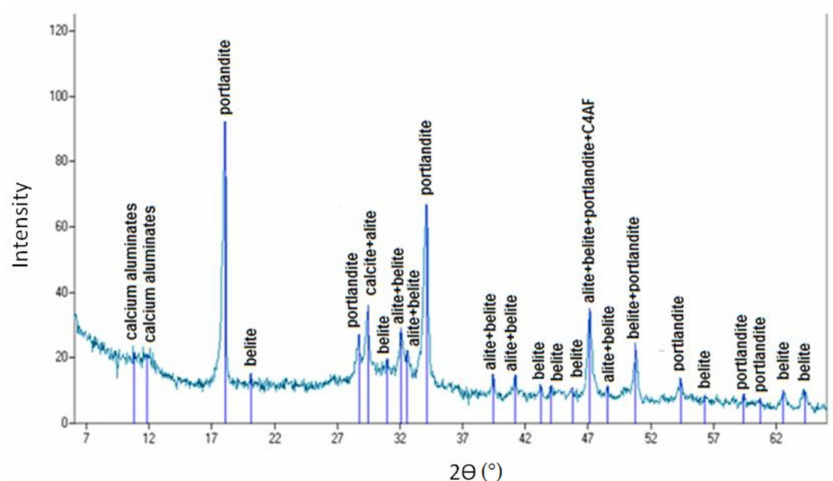
Figure 24. XRD patterns of cement paste from recycled aggregates without thermo-mechanical treatment.